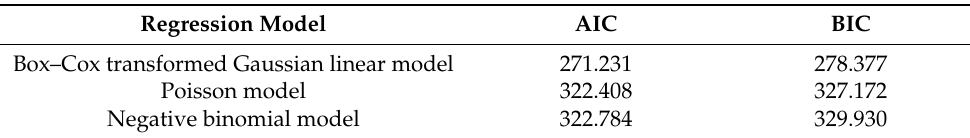
Table 2. Model selection using the Akaike information criterion (AIC) and Bayesian information criterion